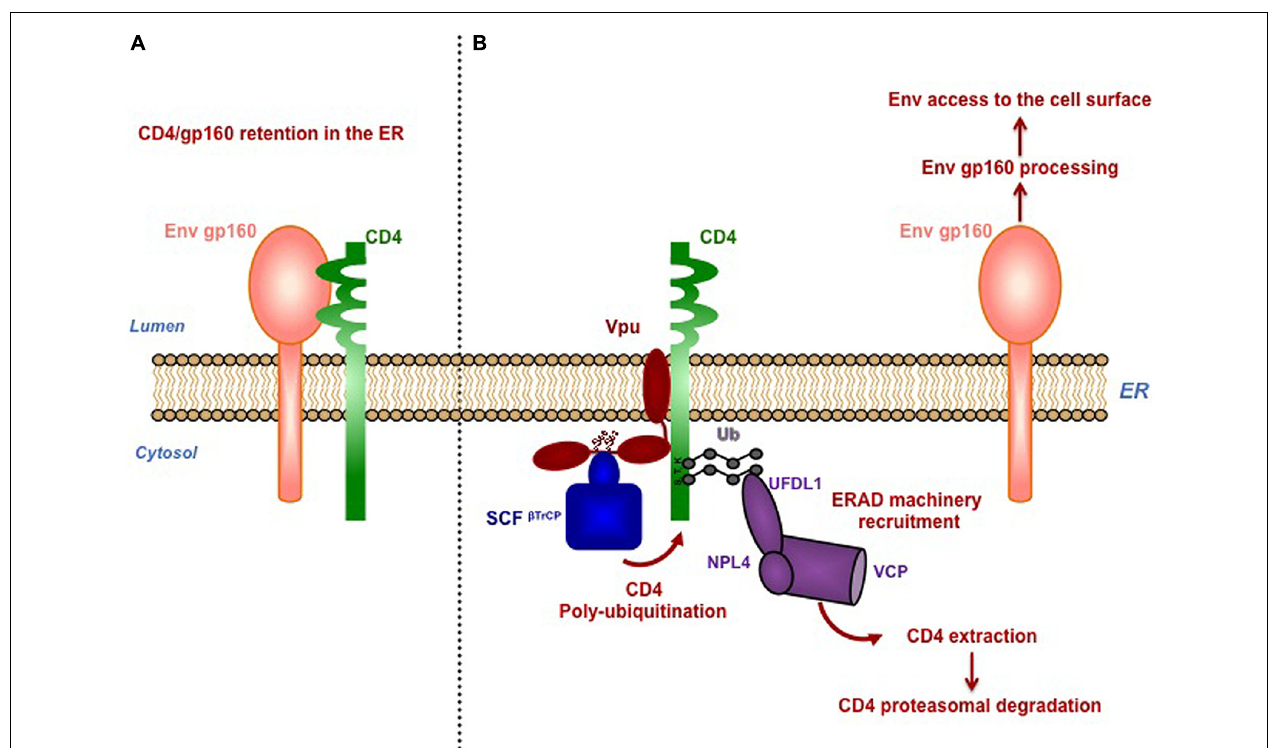
FIGURE 1 | Vpu mediates proteasomal degradation of CD4 to favor viral fitness. (A) Newly synthetized CD4 and HIV-1 envelope precursor gp160 interact in the ER through their luminal domain, preventing Env trafficking to the cell surface. (B) Vpu induces retention of CD4 in the ER through interaction via their transmembrane region and connects CD4 to SKP1-cullin1-F-Box (SCF) E3 ubiquitin ligase through binding with the SCF subunits β -TrCP1 and β -TrCP2. Interaction of Vpu with β -TrCP involves the conserved phophorylated serines S 52 and S 56 , located in the cytoplasmic tail of Vpu. Recruitment of the SCF ß-TrCP complex by Vpu induces poly-ubiquitination of CD4 on lysine, serine and threonine